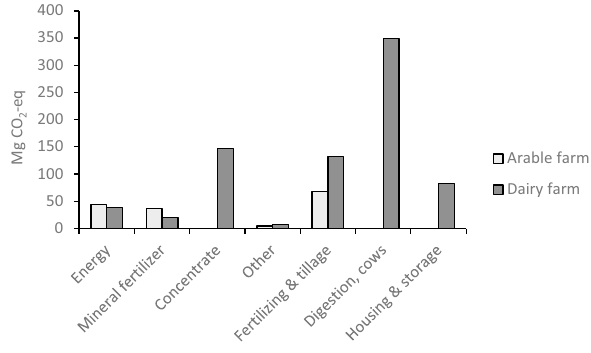
Fig. 2 Greenhouse gas (GHG) emissions from the arable farm and the dairy farm, including emissions associated with cultivating agricultural crops (fertilizer and tillage), dairy cow digestion, and manure management, calculated using conventional life cycle assessment